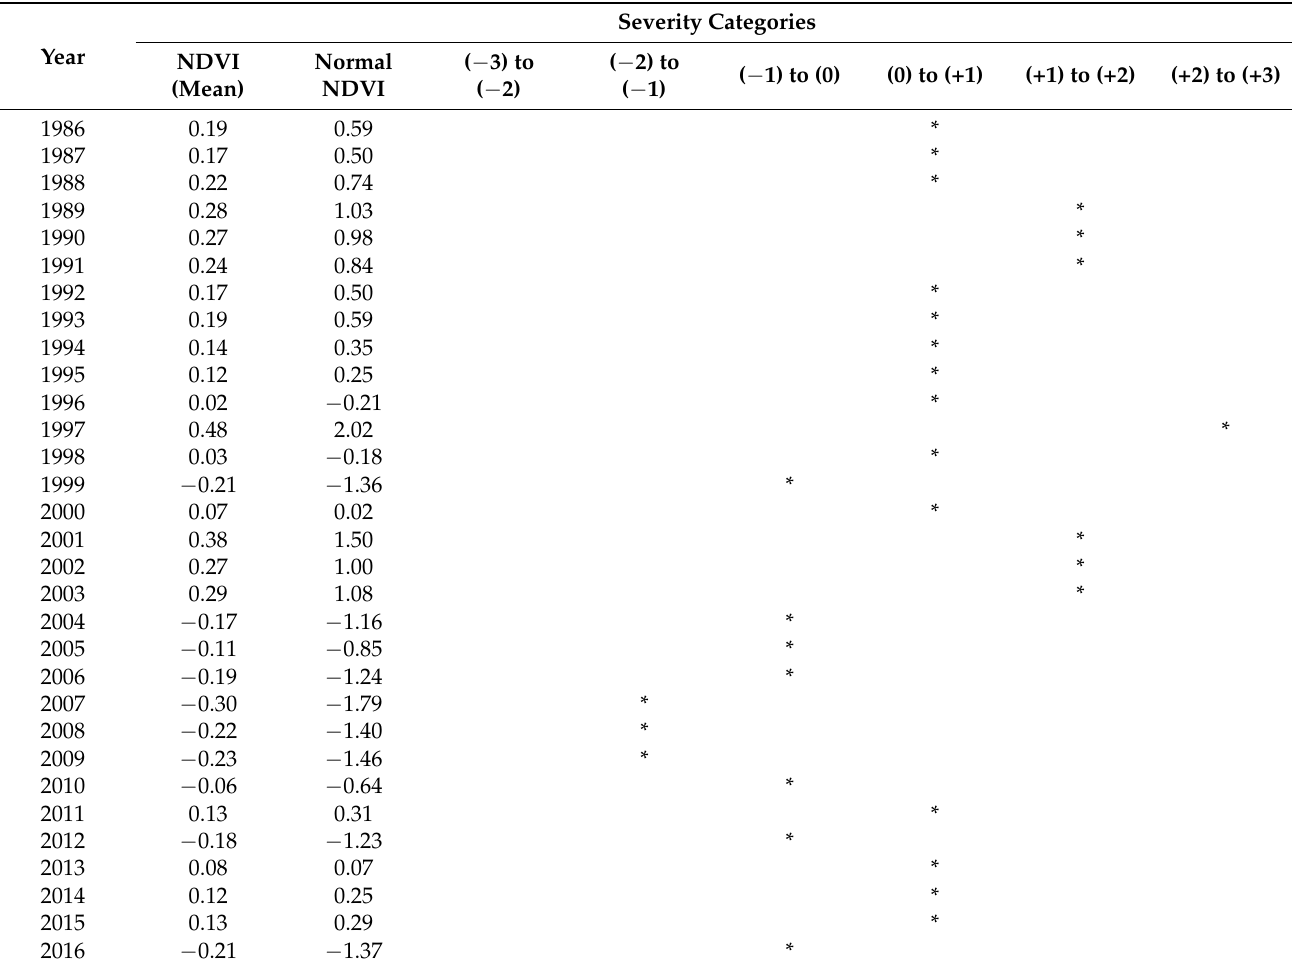
southeast of Iran) is shown in Table 3. Table 3. Hazard quantification for the Sistan & Baloochestan Province (1986–2016).